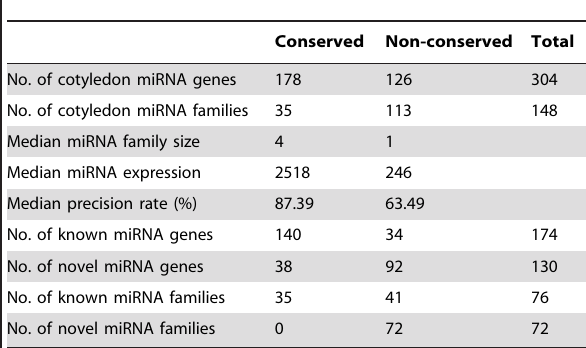
Table 1. Summary of Cotyledon miRNA Genes and